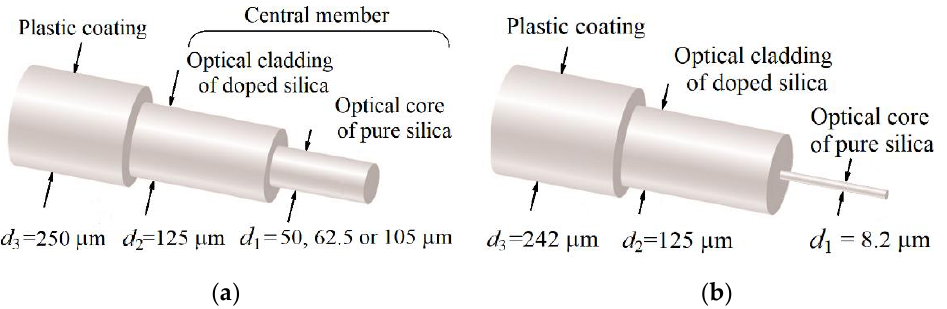
Figure 1. Schematic drawings of ordinary communication-grade silica-core silica-clad optical fibers: ( a ) multimode; ( b ) single mode. ( a ) multimode; ( b ) single